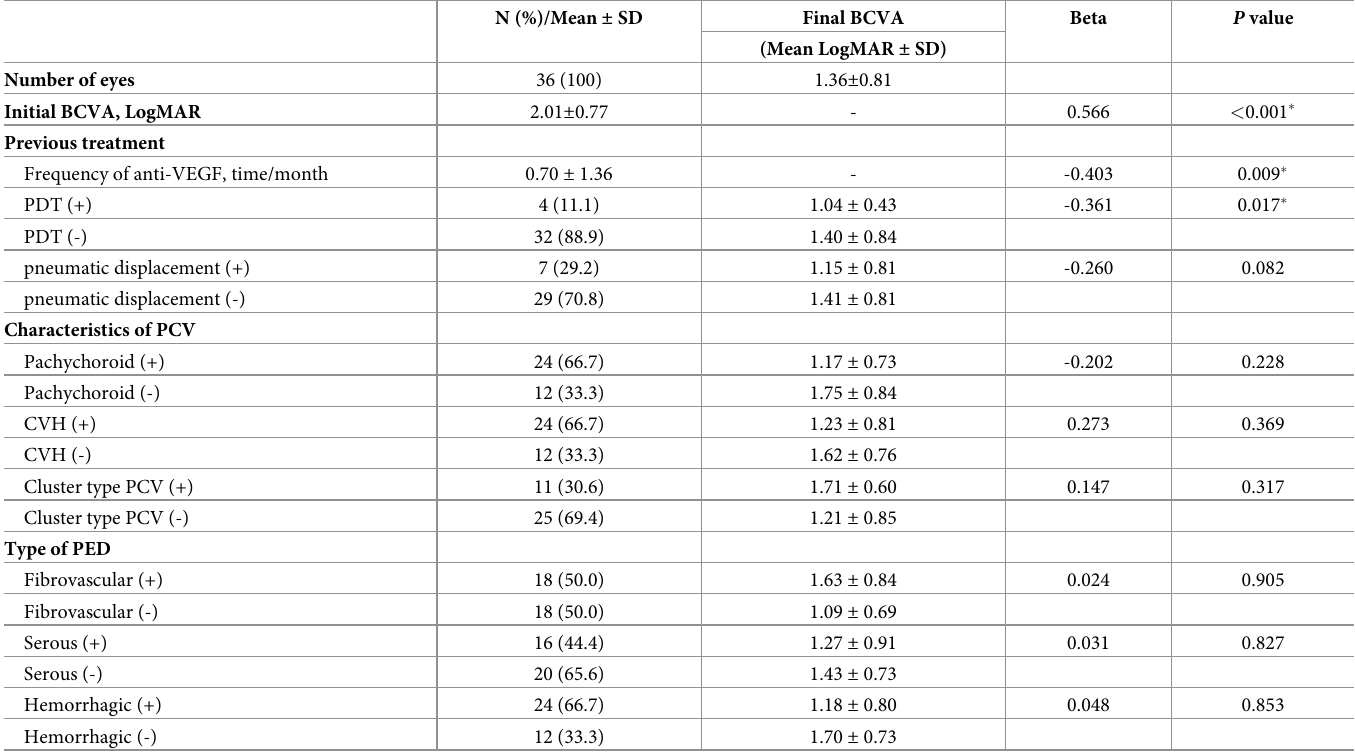
Table 4. Factors associated with visual prognosis in polypoidal choroidal vasculopathy with breakthrough vitreous